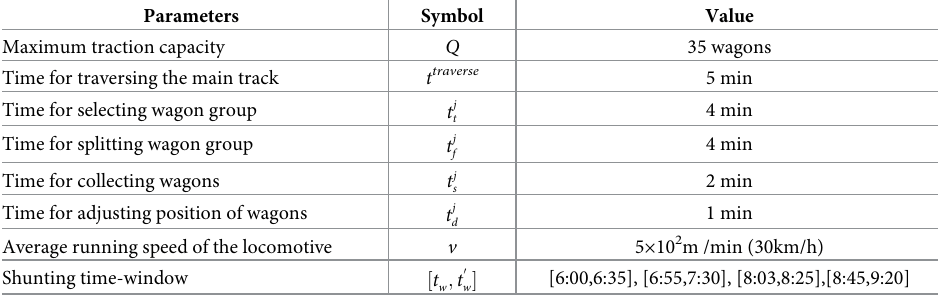
Table 2. Technical characteristics of delivering and fetching wagons operation.